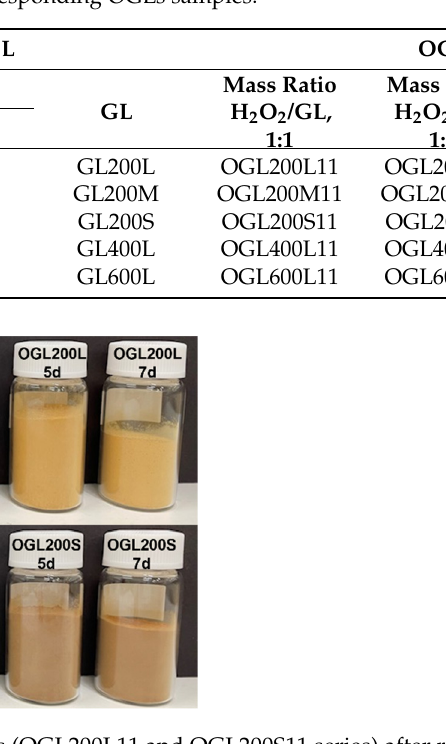
5-d and 7-d samples, in the following order: OGL200L < OGL400L < OGL600L series. OGL200L13-7d and OGL200S11/13-7d samples, respectively. The superior reactivity of GLxxxL (GL200L, GL400L, and GL600L) compared to GL200M and GL200S suggested